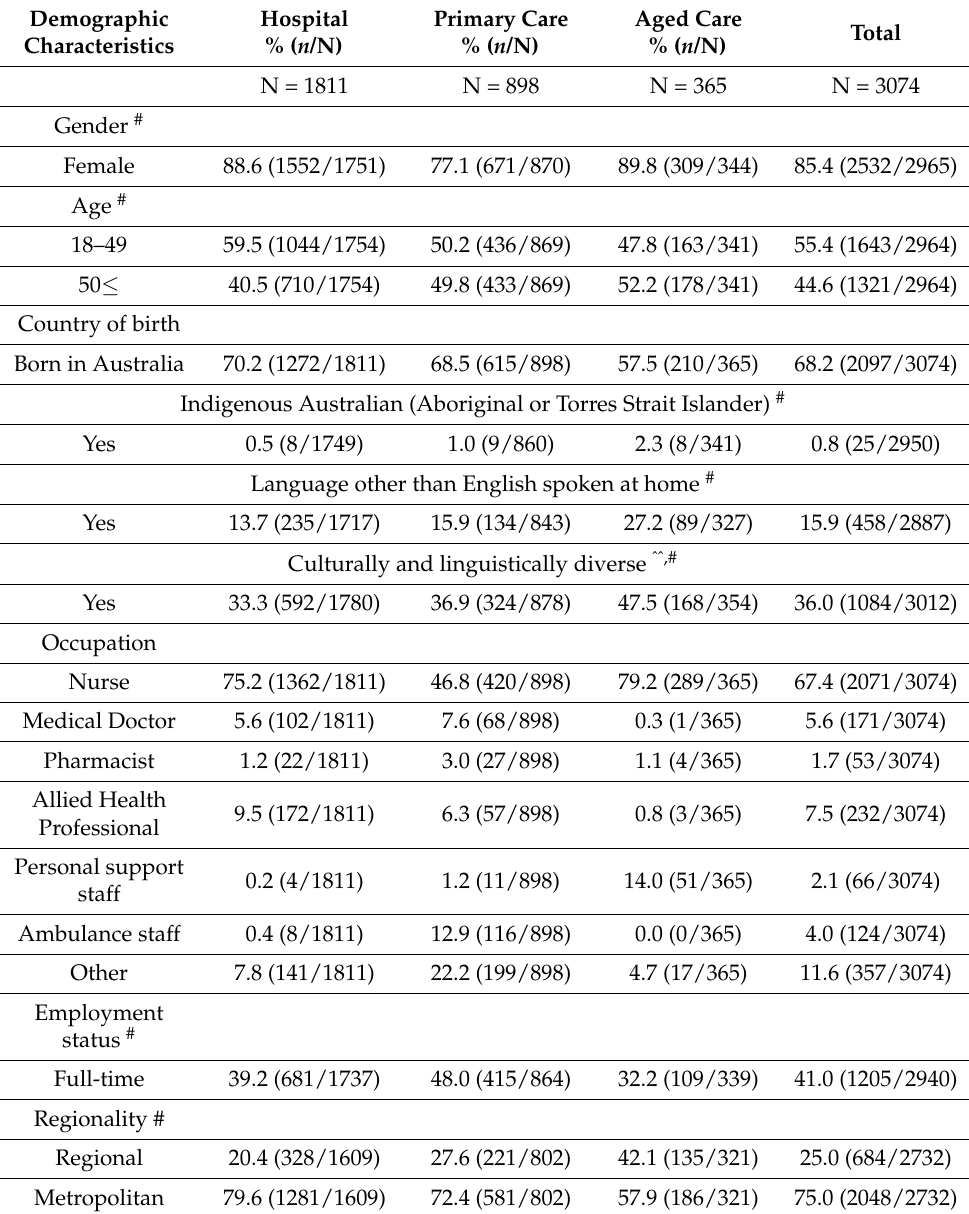
Table 1. Demographic characteristics of participants, by